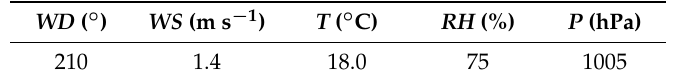
Table 1. Meteorological data from station IPOZZUOL7 in Pisciarelli, about 1 km from Solfatara. WD depicts wind direction, WS wind speed, T air temperature, RH relative humidity, P air pressure.